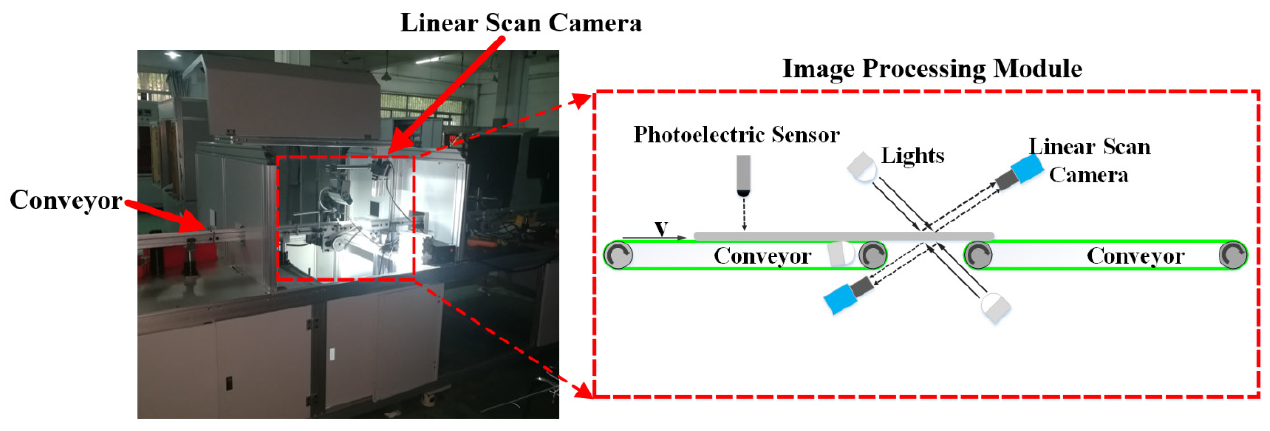
Figure 9. The detection and experimental system.